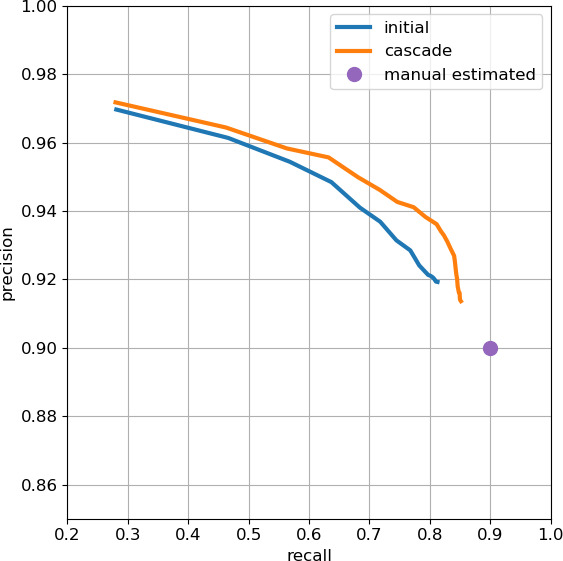
Precision-recall plot of T-bar prediction.The purple intercept indicates estimated manual agreement rate of 0.9. Data available in Appendix 1—figure 1—source data 1.Appendix 1—figure 1—source data 1.Data for Appendix 1—figure 1.Column A: initial recall; column B: initial precision; column C: cascade recall; column D: cascade precision.